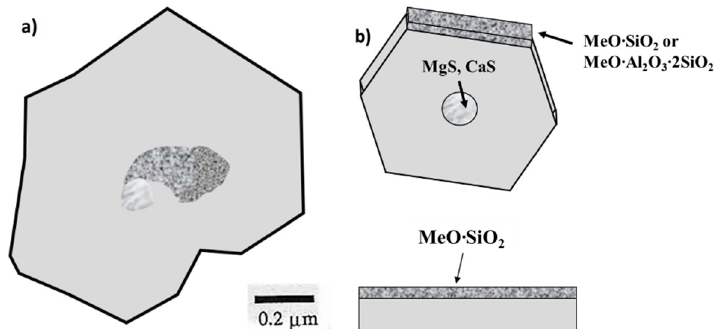
Figure 19. Pictures supporting the silicate theory: ( a ) TEM image of a silicate nucleus in SG iron; ( b ) schematic representation of the three-stage nucleation; adapted after [86]. Table 6. Calculated planar disregistry of complex oxides and silicates [86]. Inclusion Crystal System Planes